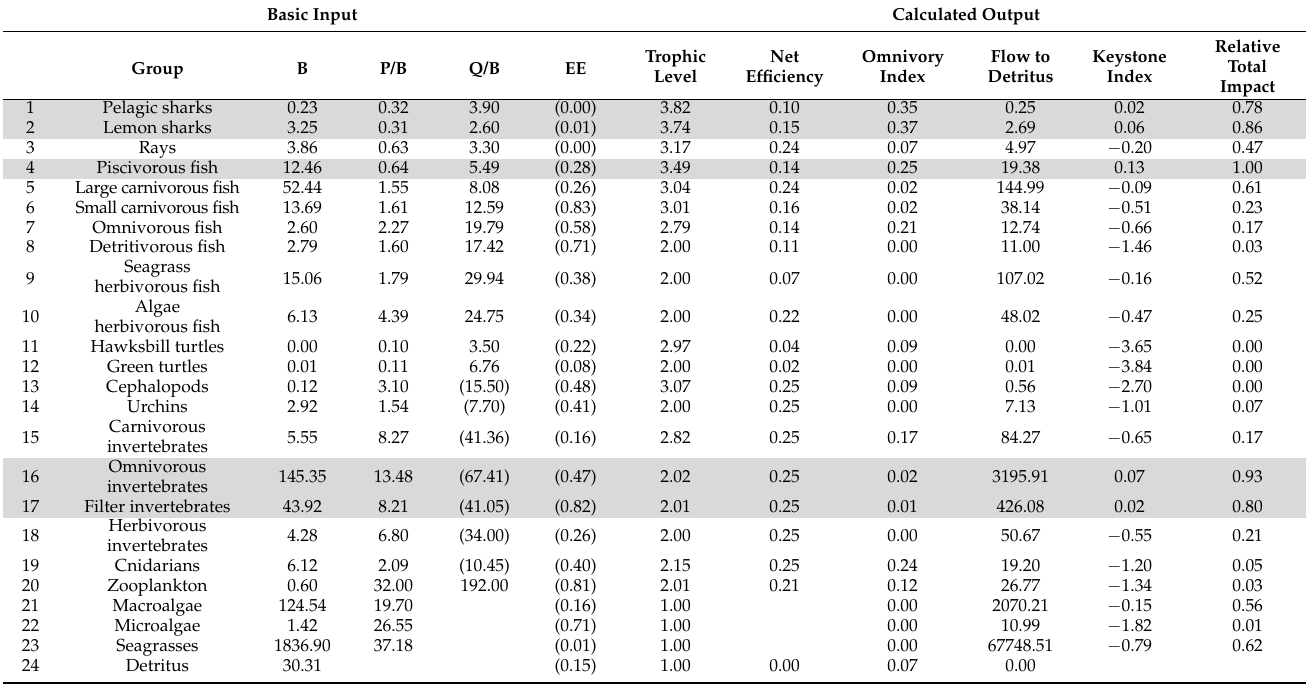
Table 1. The input parameters and calculated output of compartments in the Dongsha seagrass bed model. The values in parentheses were estimated by Ecopath. Shaded compartments are the top five influential compartments in the model by keystone index and relative total impact. B, biomass (g, wet weight (WW) m − 2 ); P/B, production/biomass ratio (yr − 1 ); Q/B, consumption/biomass ratio (yr − 1 ); and EE, ecotrophic